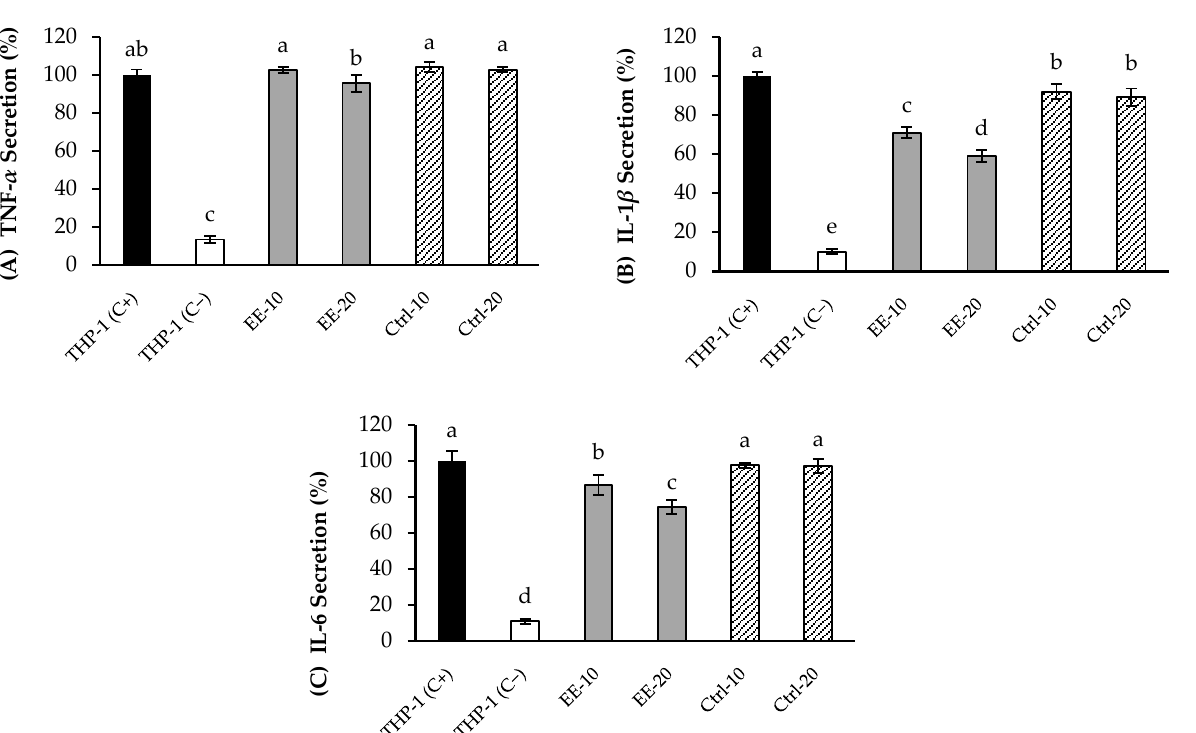
Figure 1. Levels of TNF- α ( A ), IL-1 β ( B ) and IL-6 ( C ) secreted by THP-1 macrophages activated with LPS, in presence of 10 µ L/mL (EE-10) and 20 µ L/mL (EE-20) of basolateral fraction from yarrow enriched-extract (EE). Positive control (THP-1 C+), cells stimulated with LPS without basolateral sample. Negative control (THP-1 C − ), cells stimulated with LPS in contact just with RPMI medium. Control digestion (Ctrl) represents the basolateral supernatant from digested fluids without extract at 10 µ L/mL (Ctrl-10) and 20 µ L/mL (Ctrl-20). Each bar is the mean of three determinations ± S.D. a, b, c, d, e Different letters indicate statistical differences among samples ( p < 0.05) according to Fisher’s least significant difference (LSD) procedure.